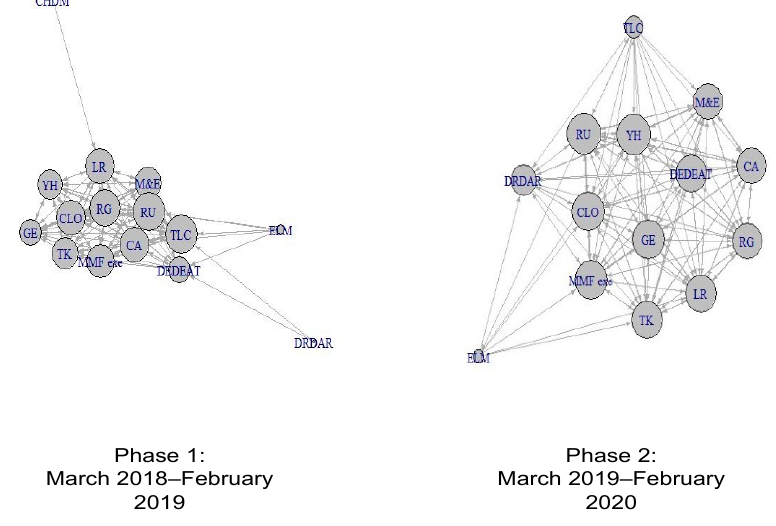
Figure 9. Overview of the Inter-organisational trust network. Arrows represent directed, weighted ties, and circle size represents degree centrality. Rhodes University (RU), Department of Economic Development, Environmental Affairs, and Tourism (DEDEAT), Department of Rural Development and Agrarian Reform (DRDAR), Chris Hani District Municipality (CHDM), Emalahleni Local Municipality (ELM), Traditional Leaders Council (TLC), Masibambisane multi-actor forum executive (MMF exe), GEF5 Community liaison officers (CLO), Conservation Agriculture Hub (CA), Land Rehabilitation Hub (LR), Rangeland Management Hub (RG), Training and Knowledge Hub (TK), M&E Hub (M&E), Gender Equity Hub (GE), and Youth Hub (YH).